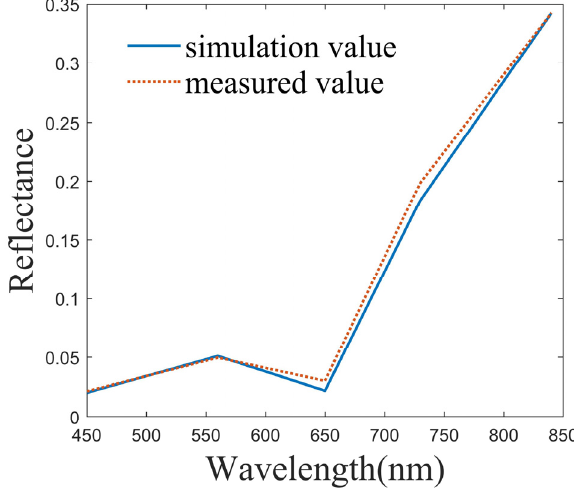
Figure 7. Comparison of simulated values and ground truth values.